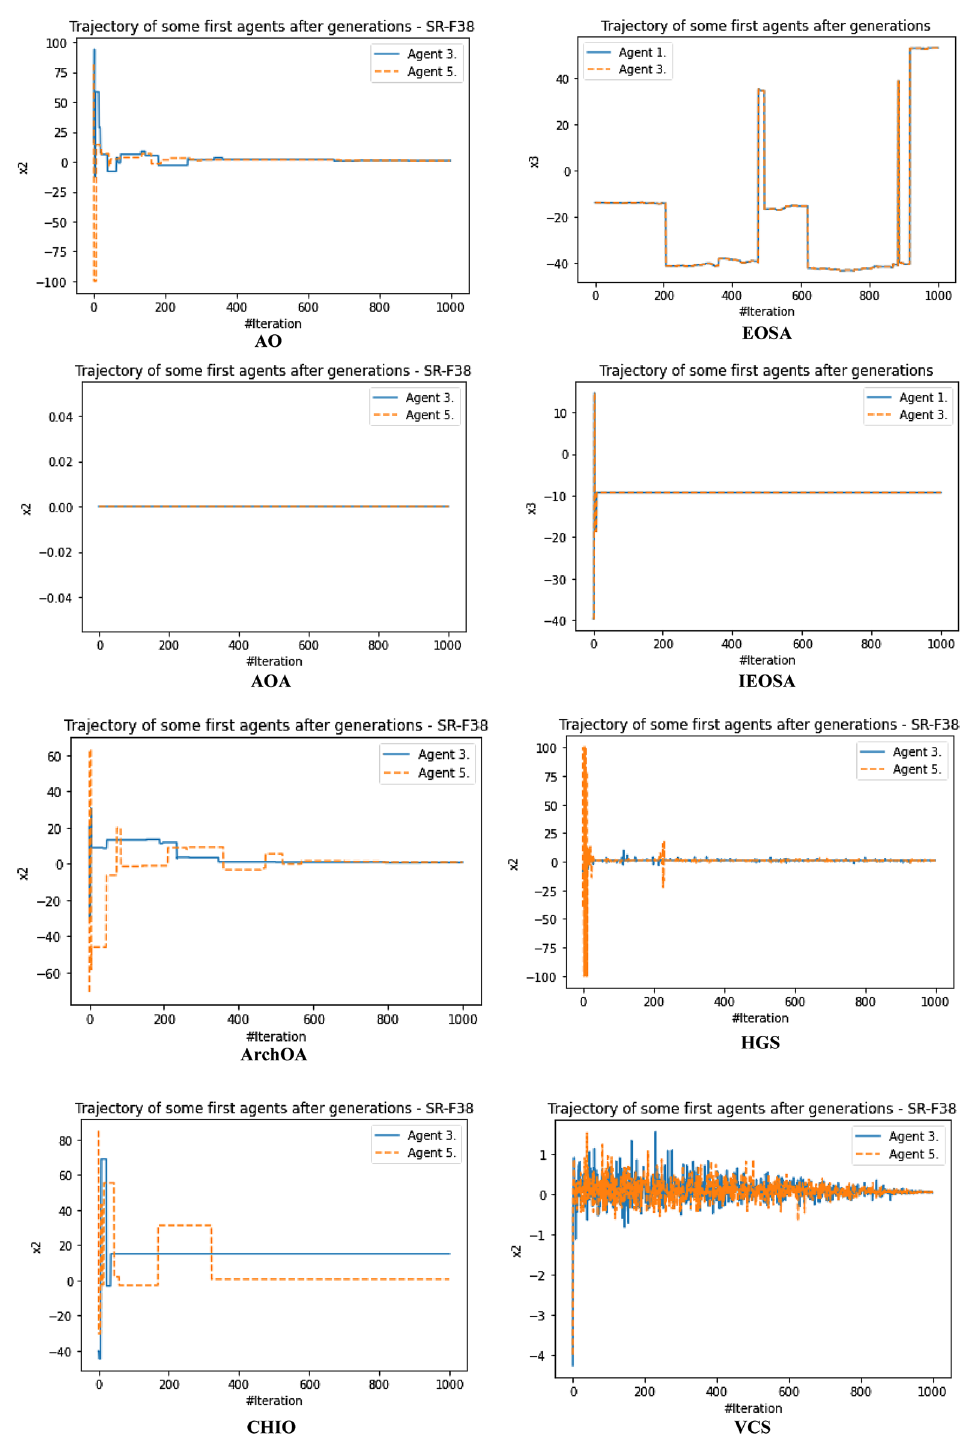
Figure 7. A comparative analysis of the trajectory for Shift-Rotated (SR) of Sum of Different Power (F13) for AO, EOSA, AOA, IEOSA, ArchOA, HGS, CHIO, VCS, GA, and